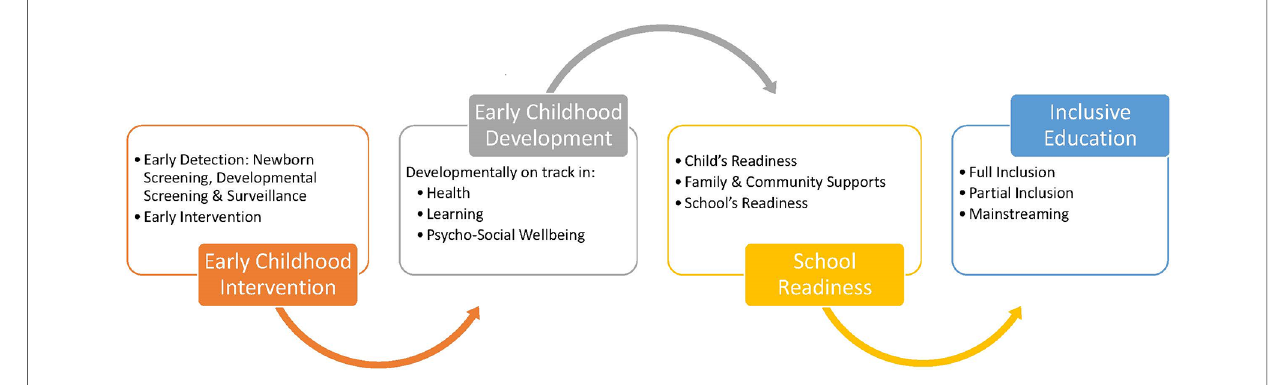
FIGURE 1 Pathway to early childhood development for inclusive education under the UN Sustainable Development Goals [source: reference